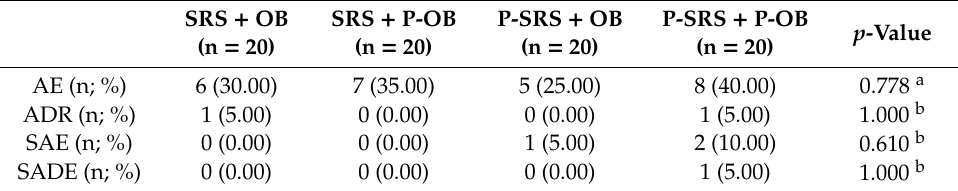
Table 7. Summarized results of safety test (safety